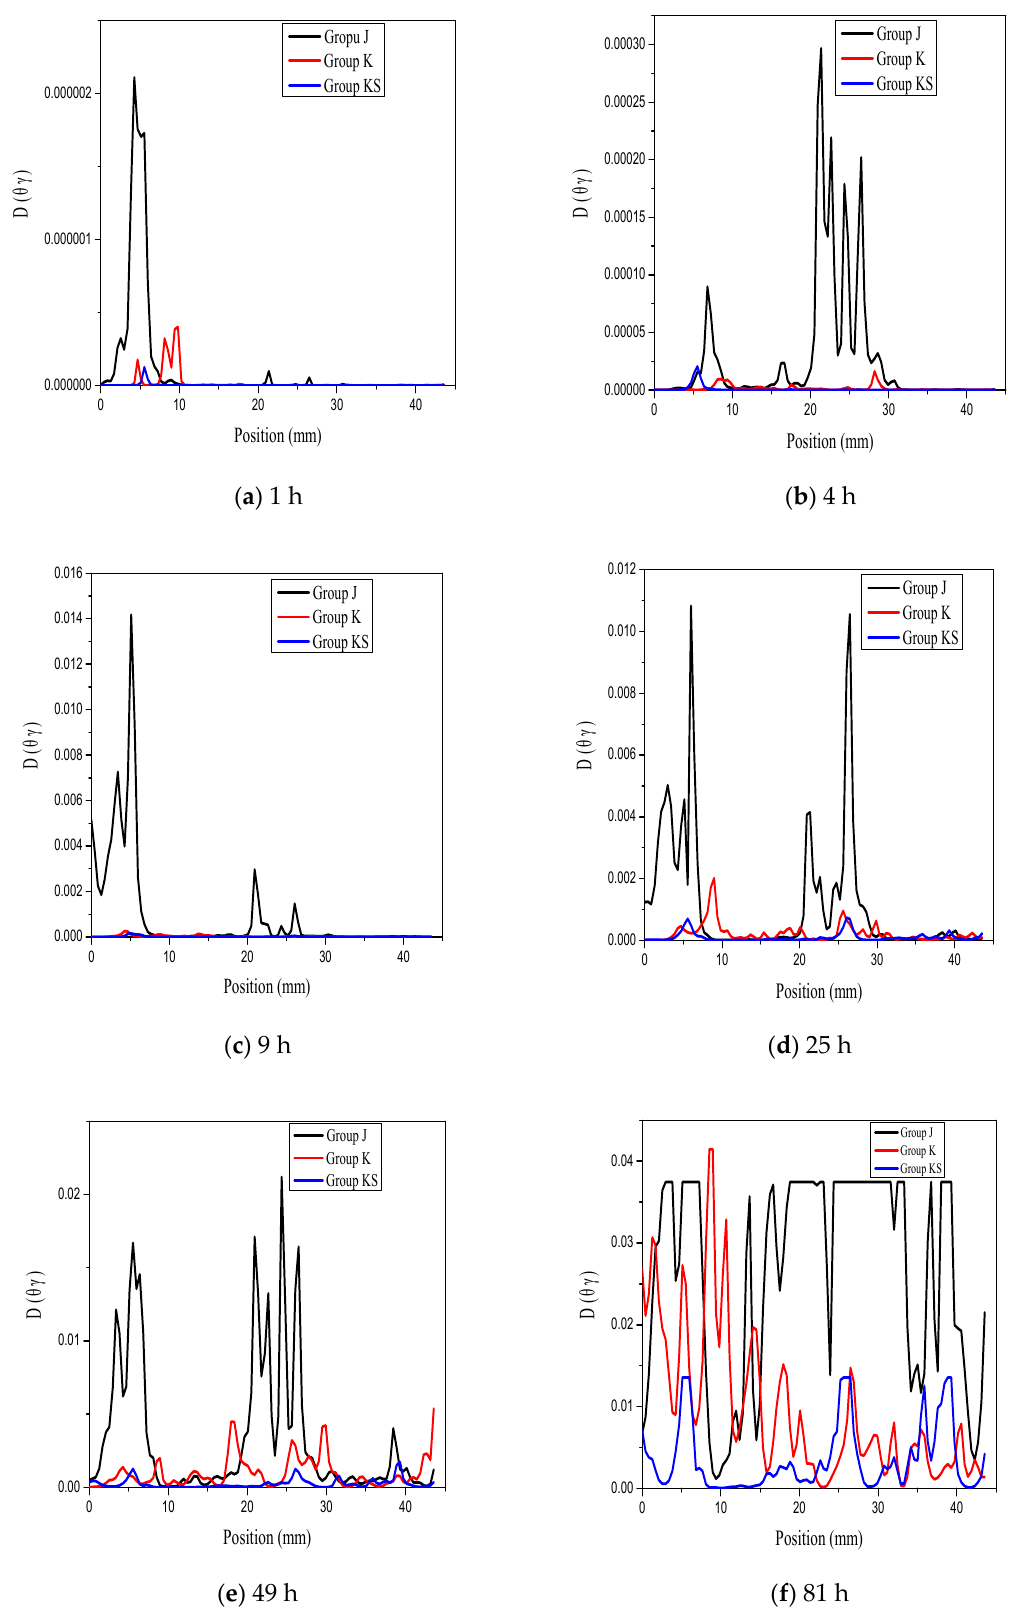
Figure 7. Comparison of the power 𝐷(𝜃𝛾) at different time intervals.